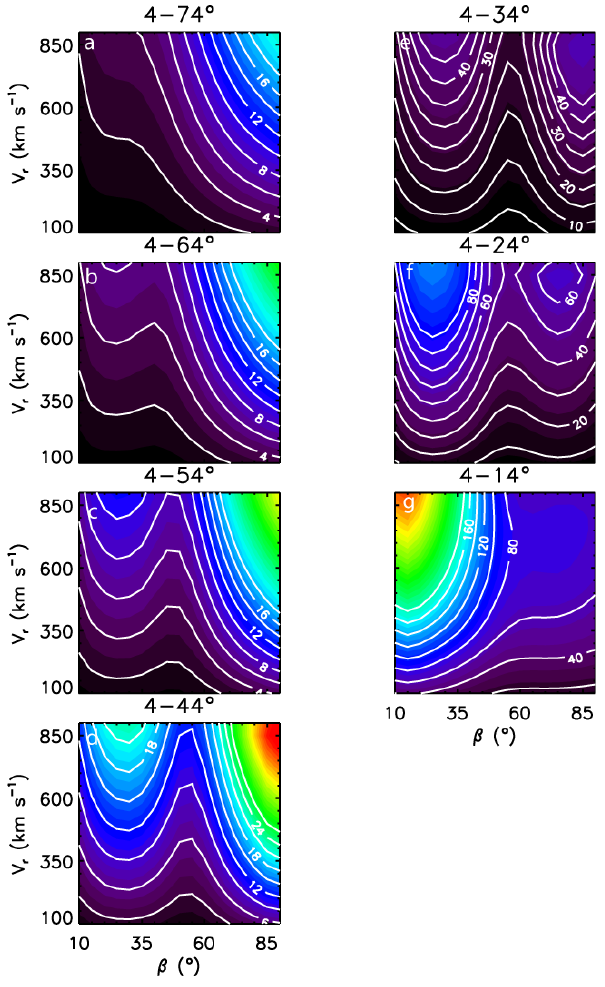
Fig. 7. Contour plots of the mean absolute error in β as a function of V r and β . Each panel is derived from fitting tracks over the elongation range given. The mean absolute error is colour coded, with black (red) corresponding to small (large) values, and values are also marked on the overlaid contours. Note that the panels in the left hand column are on a common colour scale, and those on the right are on a common but different colour